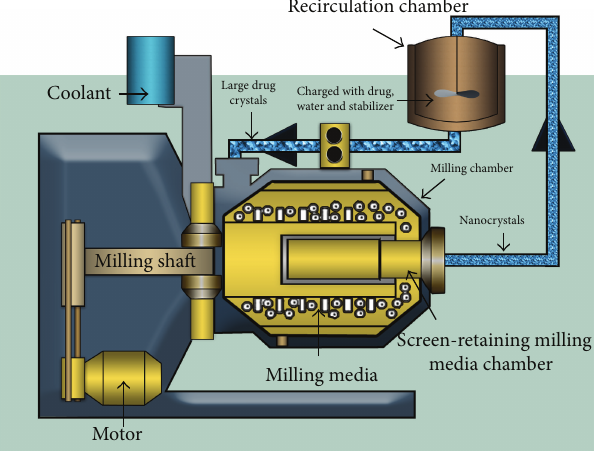
Figure 3: Schematic representation of the media milling process [11].